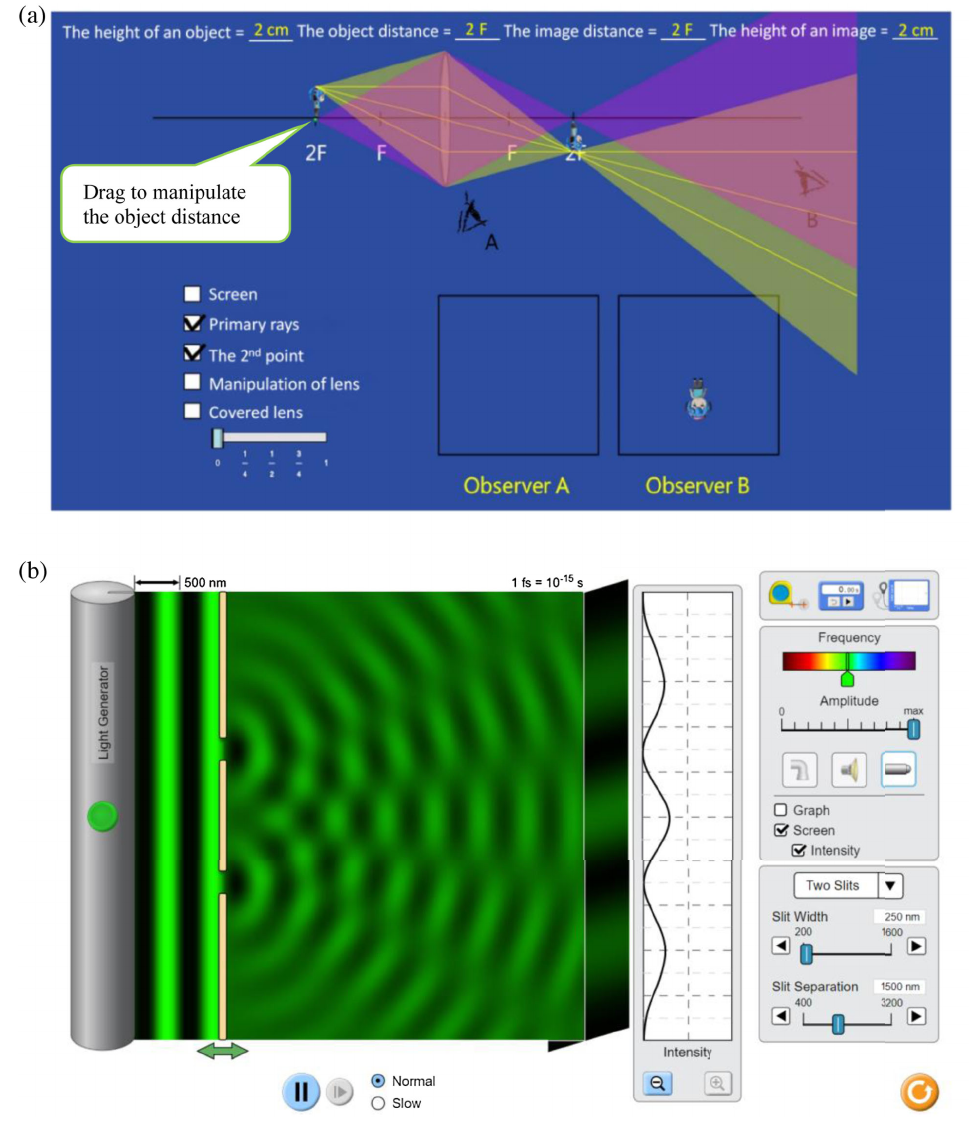
FIG. 4. Computer simulations in (a) image formation by a thin converging lens and (b) Young ’ s experiment using